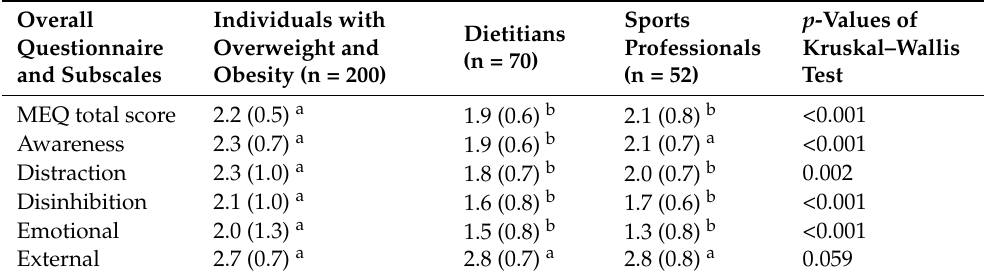
Table 3. MEQ score and subscales score per general population, dietitians and sport